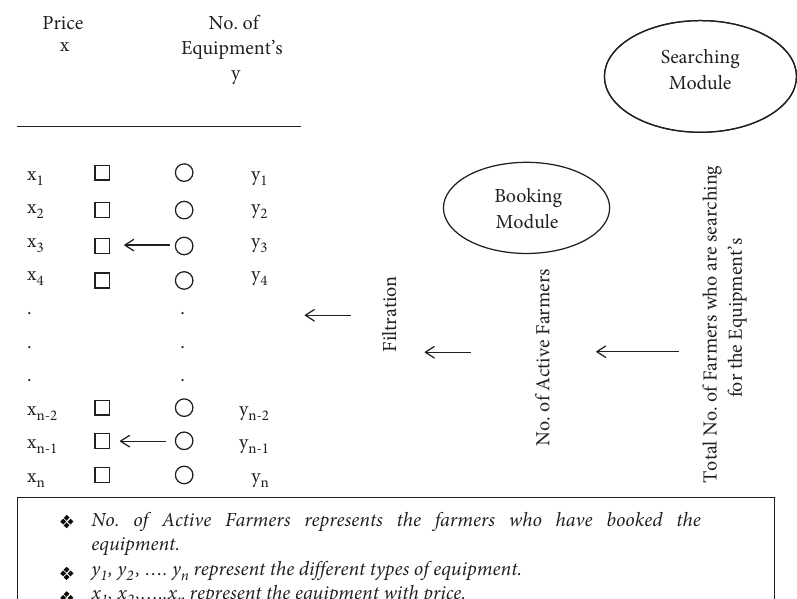
Figure 4: Price prediction based on